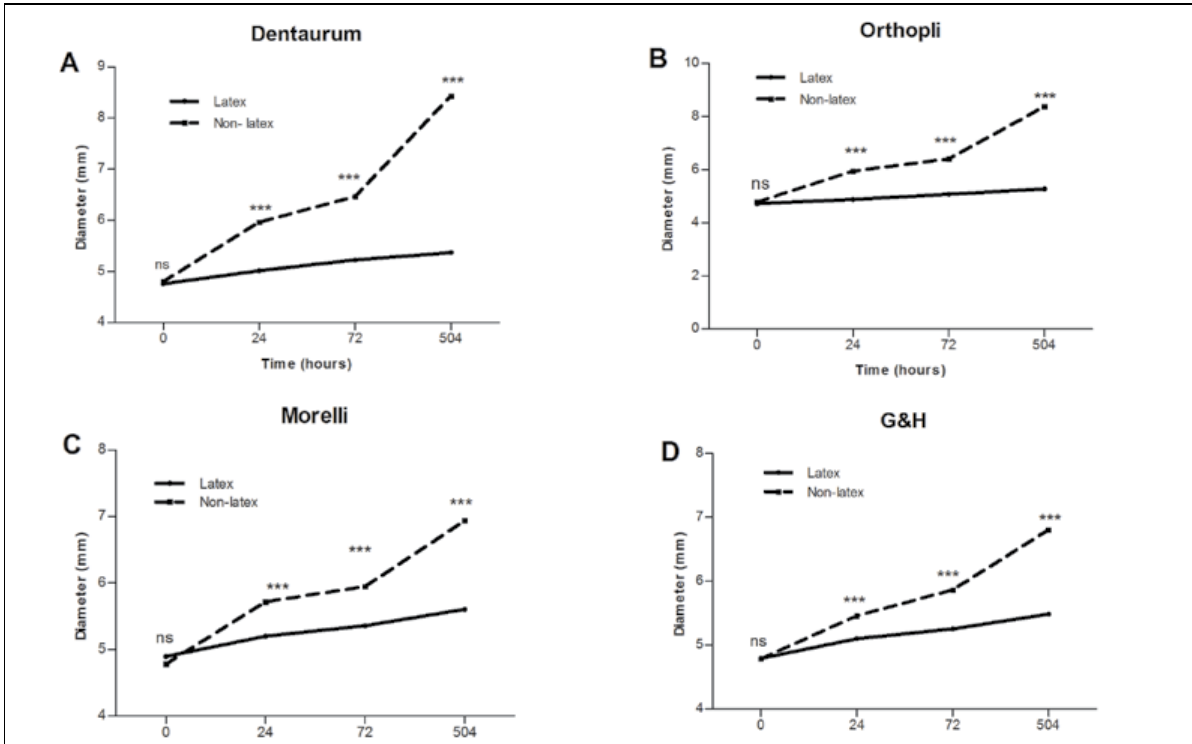
Figure 5. Comparison between the means of internal diameter of the elastic latex and non-latex: Dentaurum, Orthopli, Morelli and G&H, in all experimental periods. *** p < 0.001; ns = not significant.